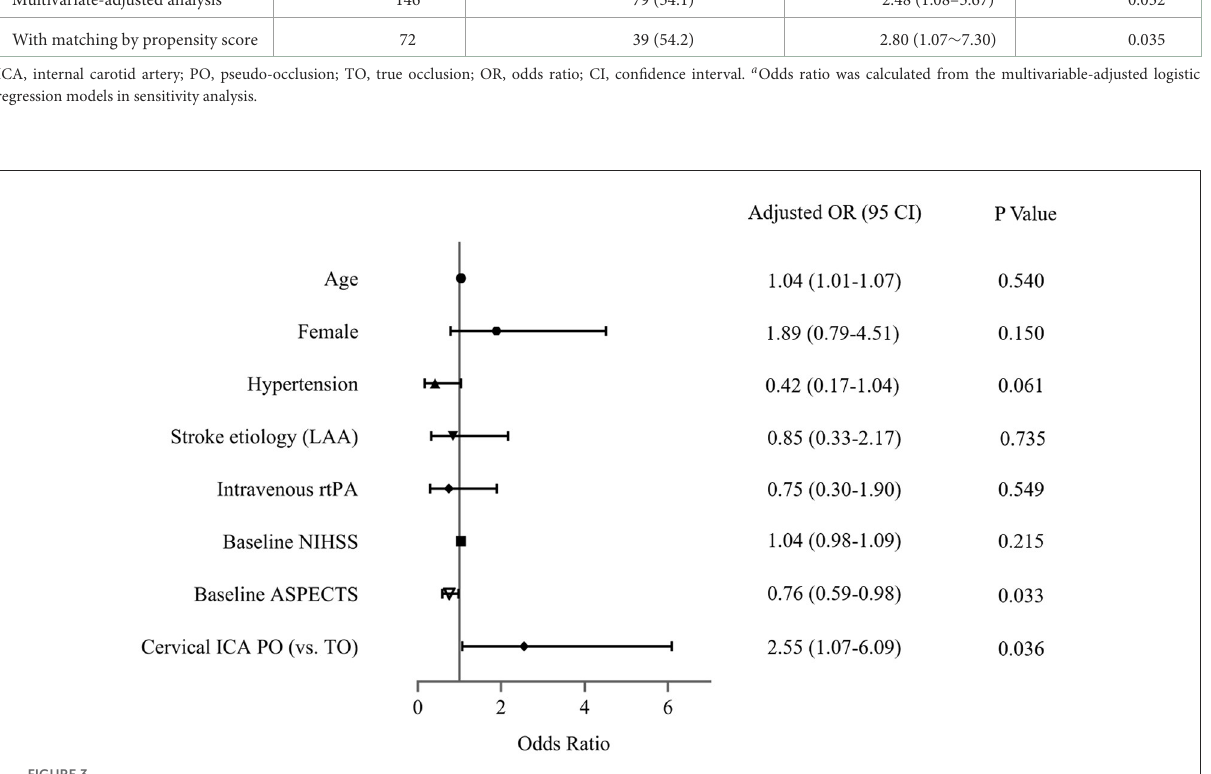
FIGURE3 Assessment of association between cervical internal carotid artery (ICA) pseudo-occlusion (PO) and reperfusion in the sensitivity analysis. LAA, large arterial atherosclerosis; rtPA, recombinant tissue plasminogen activator; NIHSS, National Institutes of Health Stroke Scale; ASPECTS, Alberta Stroke Program Early CT Score; TO, true